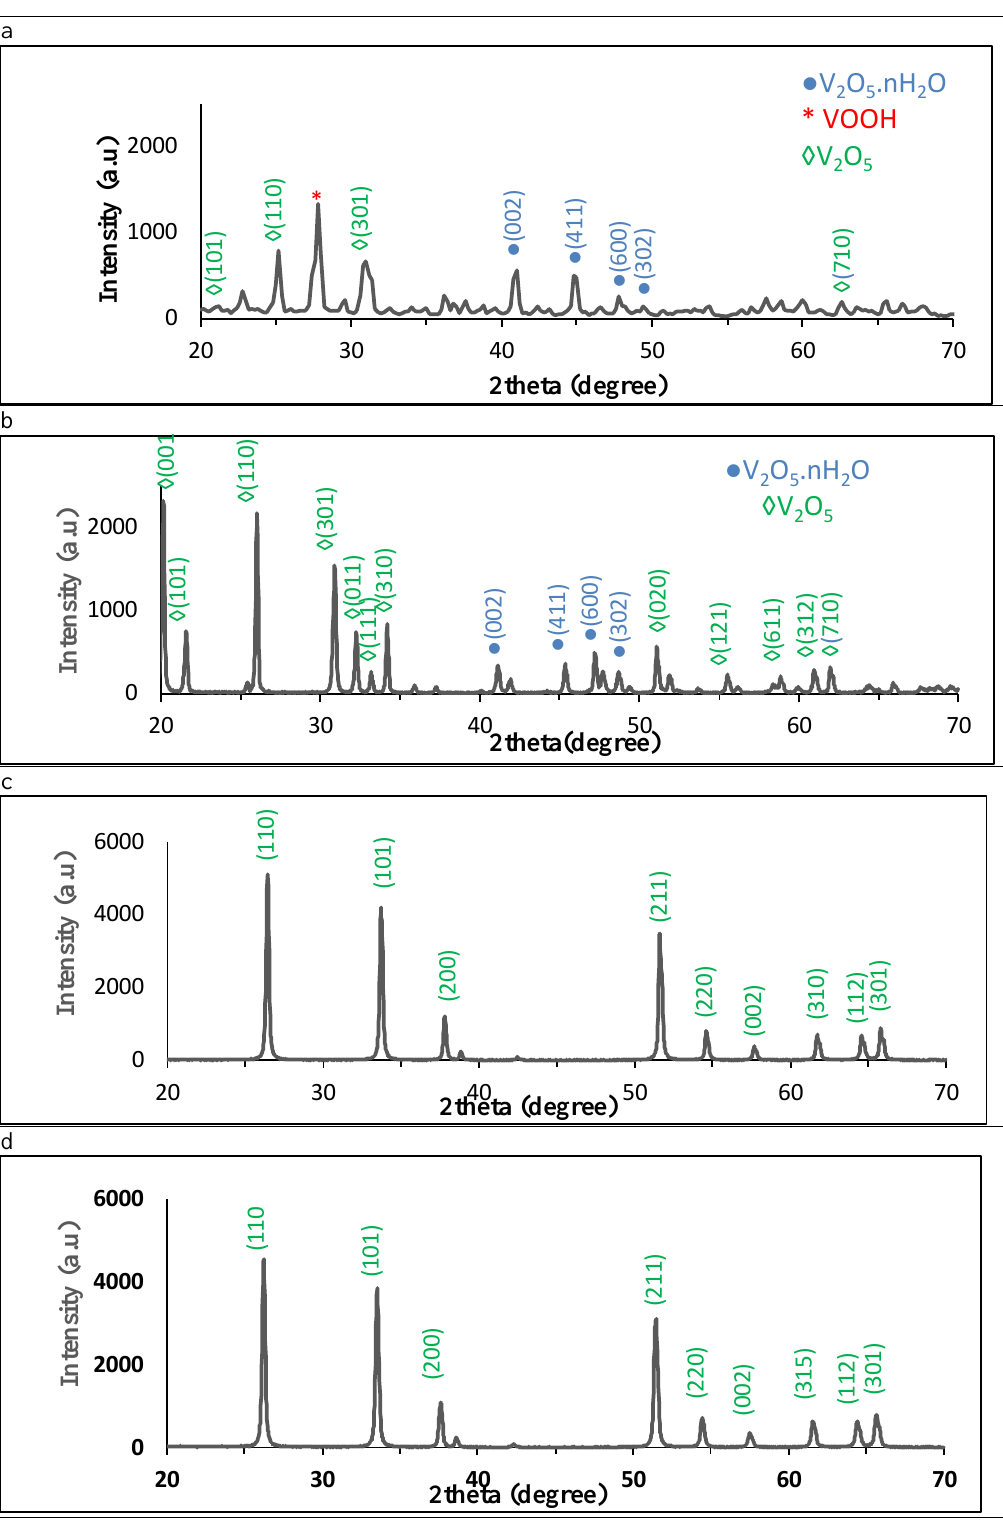
Figure (3): XRD of V 2 O 5 a: as-prepared, b: annealing at 500 o C and SnO 2 c: as-prepared, d: annealing at 500 o